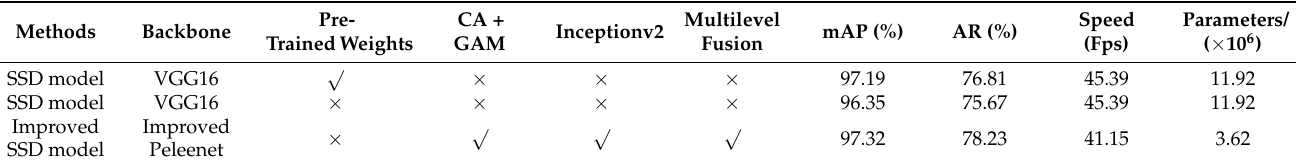
Table 1. Whether to load the pre-trained weights detection evaluation indicator